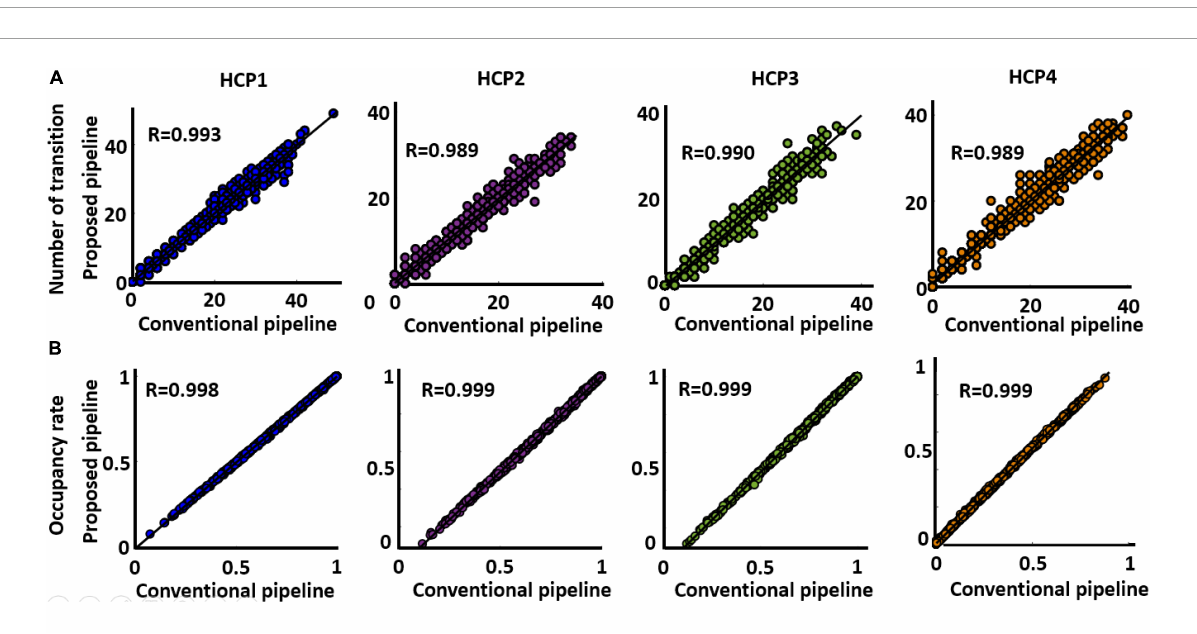
FIGURE6 Both standard and the proposed dFNC pipeline generated similar dFNC features replicated across four datasets. (A) Estimated number of transitions from both standard and proposed pipeline for all HCP datasets. The similarity between the estimated number of transitions from both methods is more than 0.989. (B) Estimated occupancy rate (OCR) from both standard and proposed pipeline for all HCP datasets. The similarity between the OCR from both method is more than 0.989 ( p < 0.0001, N =